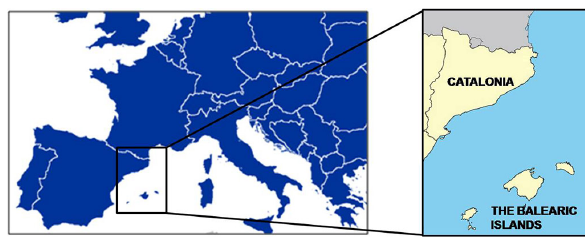
Figure 1. Geographical situation of Catalonia and the Balearic Is- lands.